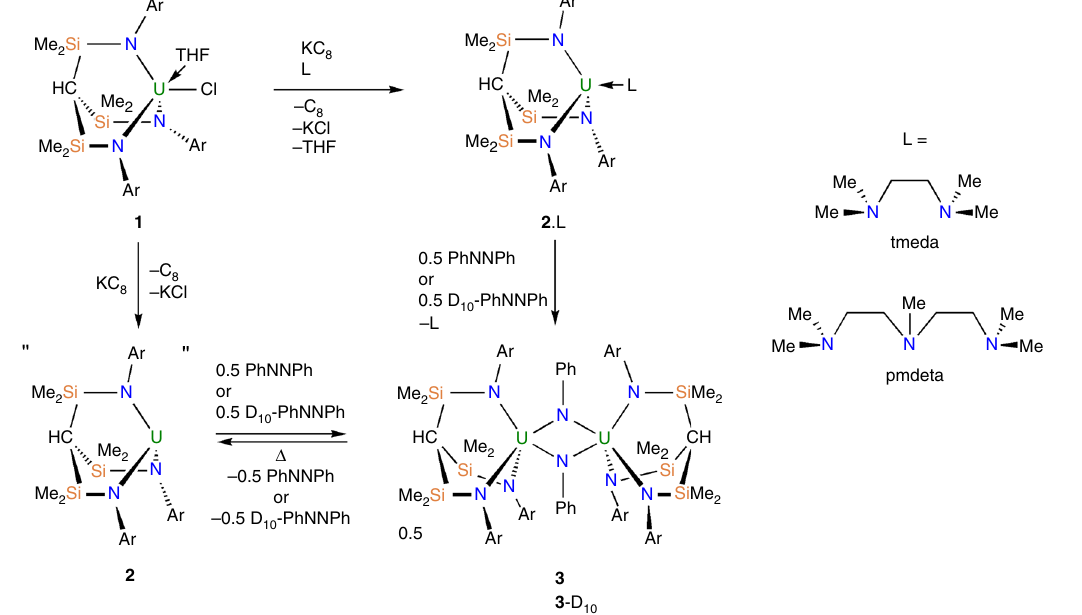
Fig. 2 Synthesis and reactivity of 3 . Reduction of 1 by different routes involving either reduction in the presence of stabilising polyamines to give 2 .tmeda or 2 .pmdeta, which react with azobenzene or D 10 -labelled azobenzene to give 3 , or a one-pot approach via 2 . Thermolysis of 3 extrudes azobenzenes by a concerted process to presumably regenerate 2 , but the latter decomposes under thermolytic conditions. Ar = 3,5-Me 2 C 6 H 3